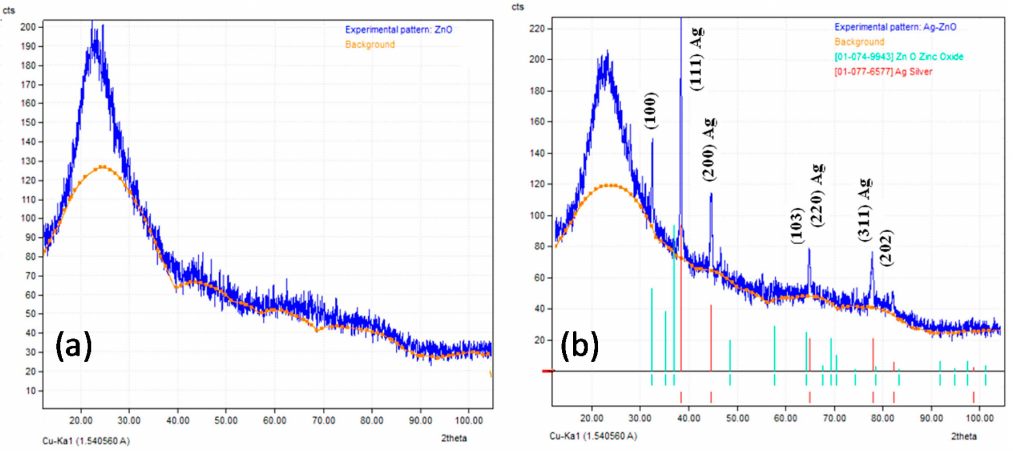
Figure 4. XRD patterns of ( a ) ZnO nanoparticles and ( b ) Ag/ZnO nanoparticles.